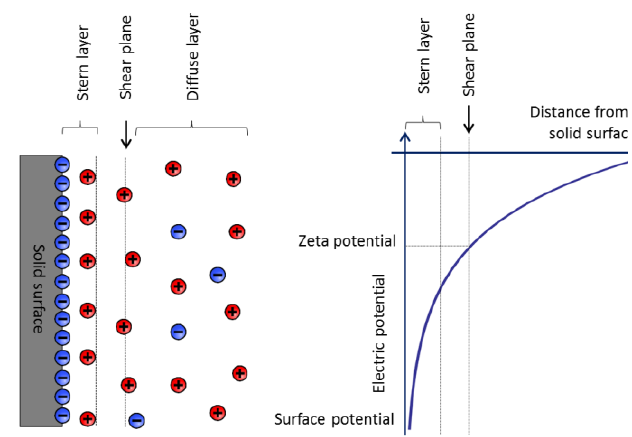
Figure 1: Stern model for the charge and electric potential distribution in the electric double layer at a solid-liquid interface. In this figure, the solid surface is negatively charged and the mobile counter-ions in the diffuse layer are positively charged (in most rock-water